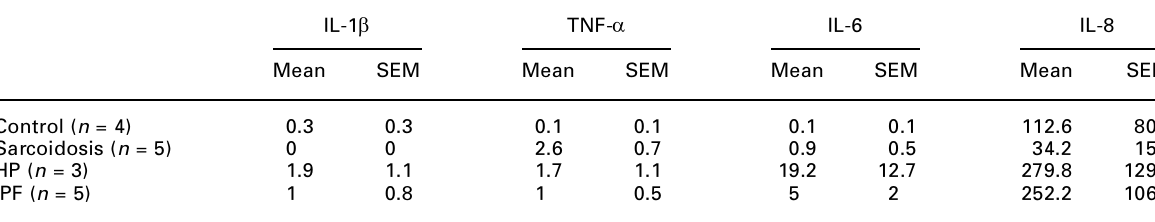
Table 2. Bronchoalveolar fluid concentration of inflammatory cytokines